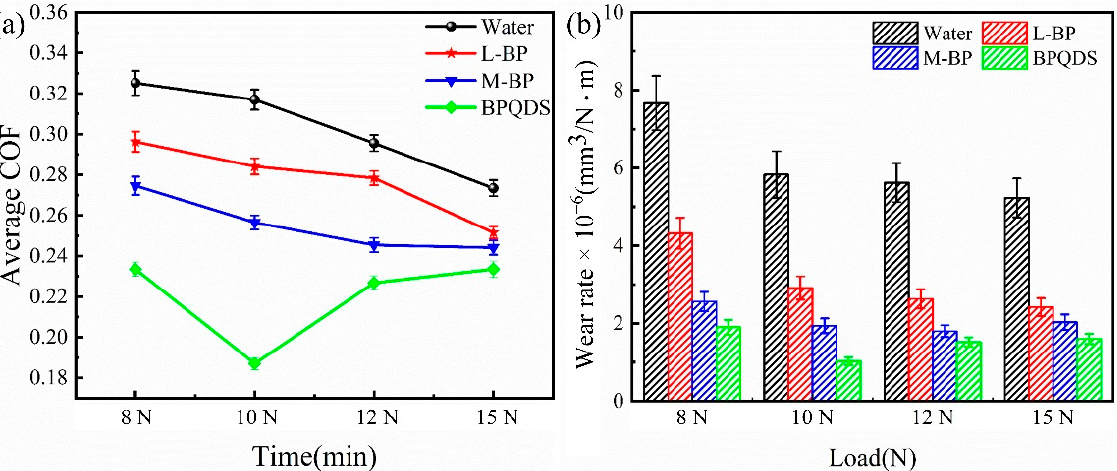
Figure 7. Tribological properties of different lubrication additives with different loads: ( a ) average COF, ( b ) wear rate (0.075 wt.%, 150 r/min, 0.5 h).